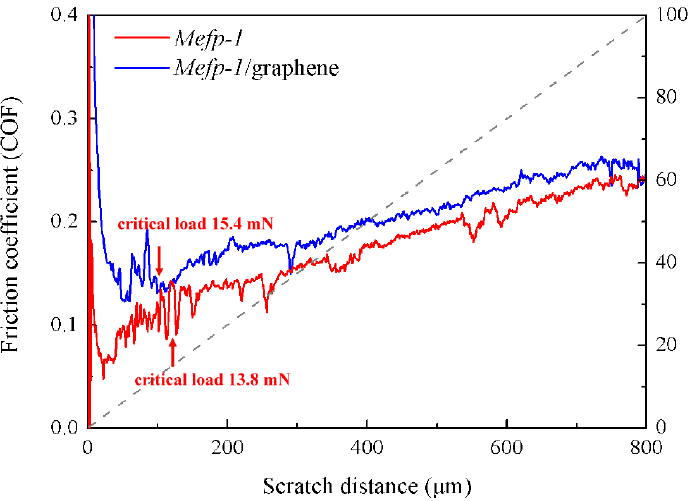
Figure 4. Coefficient of friction (COF) changes in the nano-scratch tests. The dashed line indicates the applied ramping load.